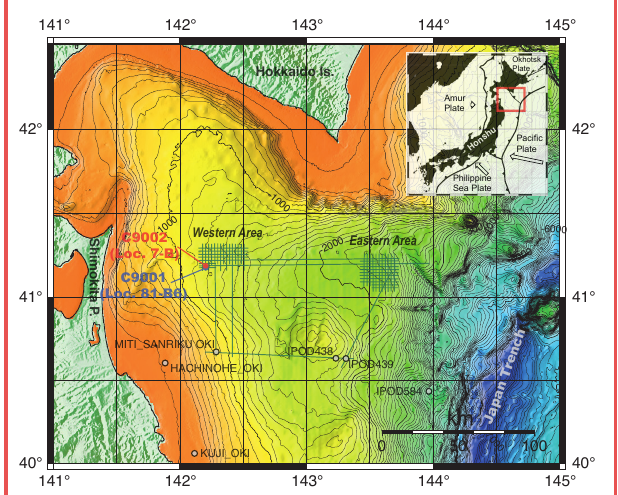
Figure 1. Location of non-riser and riser shakedown operations in the Shimokita area, offshore Tohoku, Honshu, Japan (red and blue circles). Green lines indicate locations of site survey and hazard survey seismic acquisition lines. White circles indicate the locations of previous drilling operations in the area: MITI hydrocarbon exploration wells (Kuji-Oki, Sanriku-Oki, and Hachinohe-Oki) and IPOD (or DSDP) sites 438, 439 and 584 (also referred to as DSDP sites 56, 57, and 87). Inset map indicates regional location and tectonic